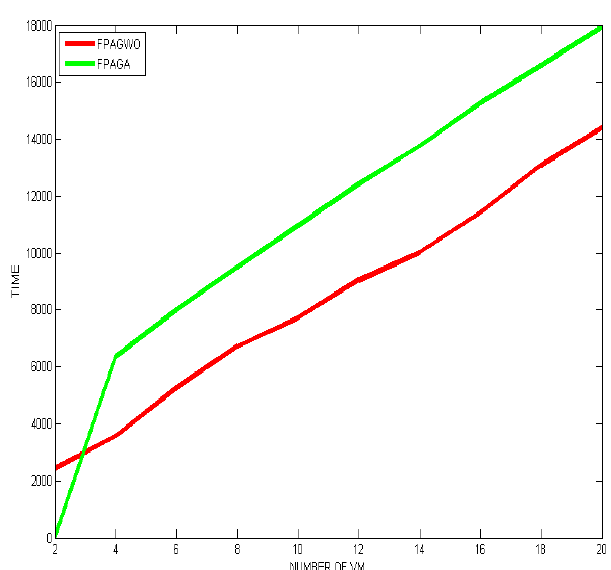
Figure 4. Time on LIGO workflow for FPA_GWO and FPA_GA